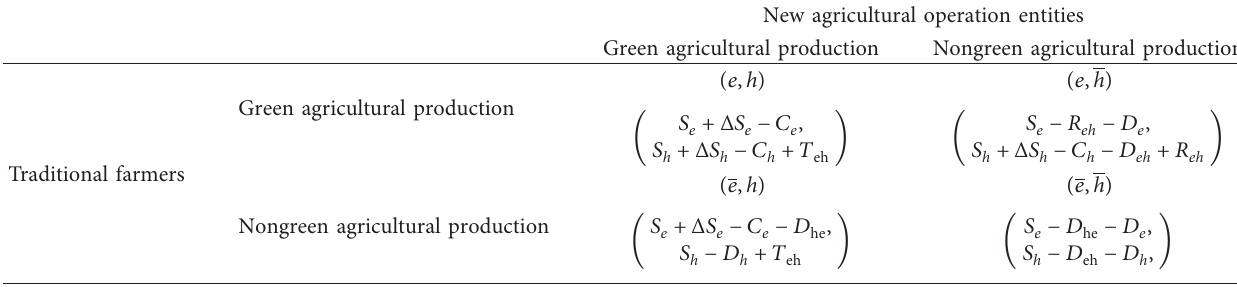
Table 1: The pairwise game matrix between traditional farmers and new agricultural operation entities under the market mechanism.